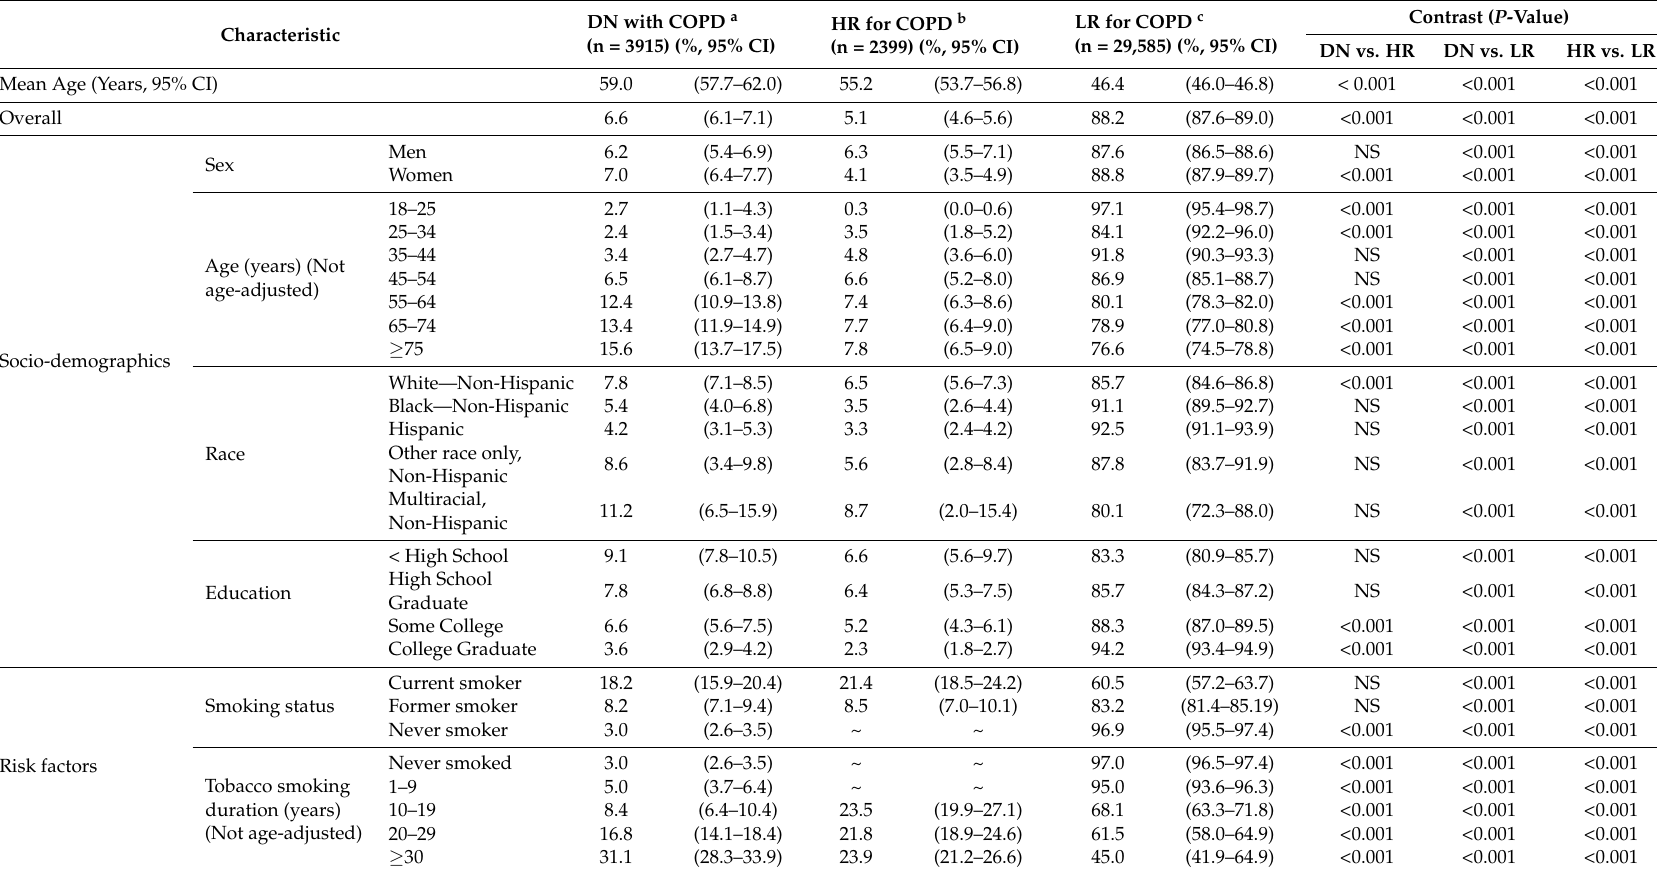
Table 2. Age adjusted prevalence and 95% confidence intervals (CI) of selected characteristics adults aged ≥ 18 years by COPD risk status a–c using BRFSS, 2015 among Four States (FL, KY, SC,